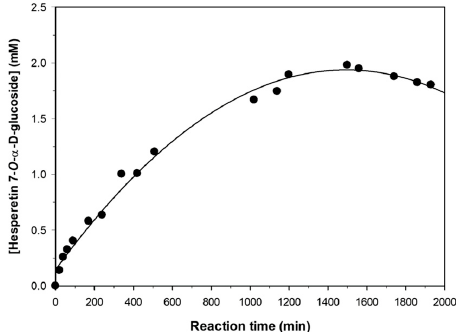
Figure 7. Progress of hesperetin glucosylation catalyzed by CGTase from Thermoanaerobacter sp. under the optimal conditions: hesperetin (15 mg/mL), soluble starch (180 mg/mL), CGTase (10% v / v ), bis(2-methoxyethyl) ether (30% v / v ), 10 mM sodium citrate buffer pH 5.0 (60% v / v ), 60 °C, 1000 rpm.